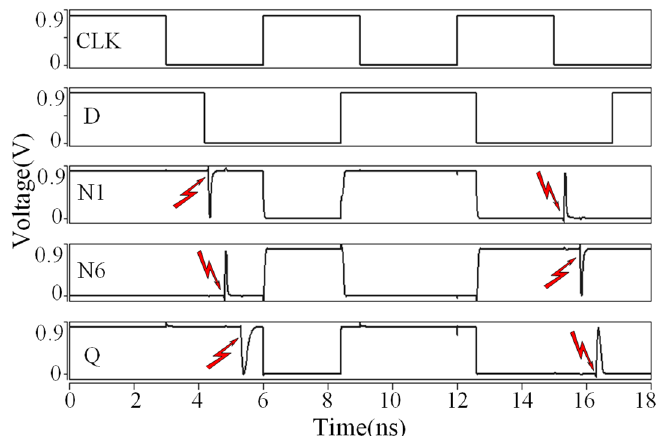
Figure 10. HLTNURL latch simulation: SNU injections.